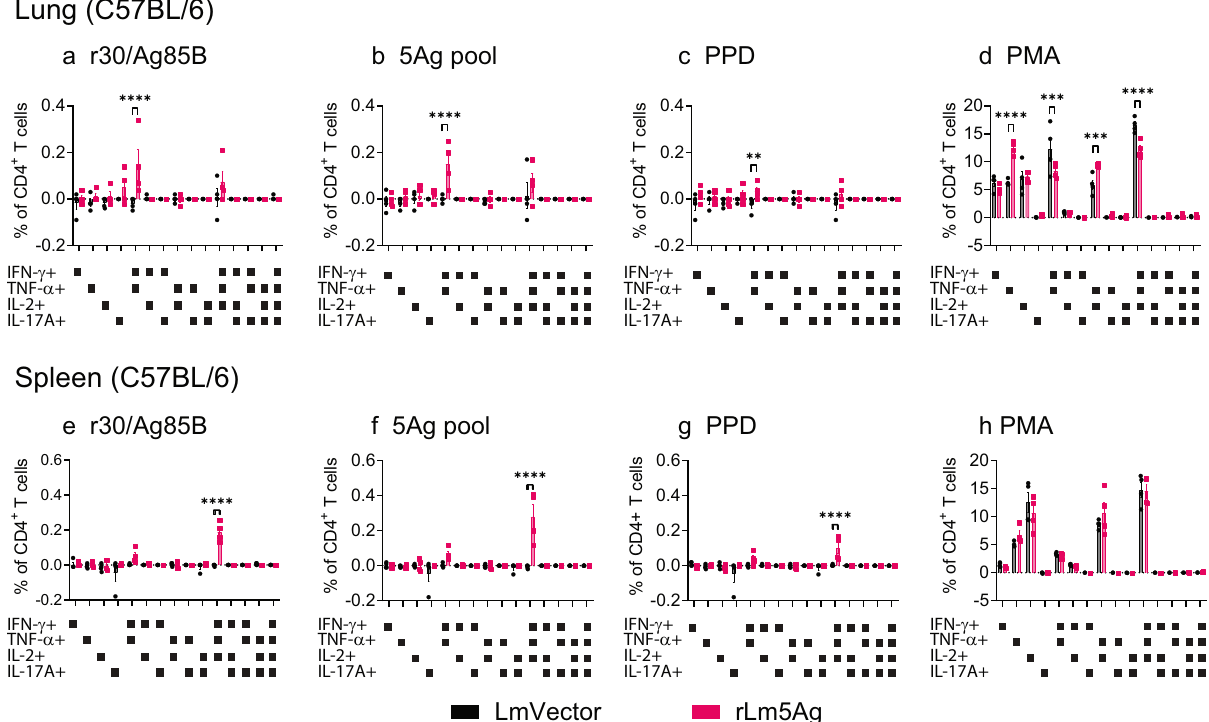
Fig. 3 Frequency of polyfunctional cytokine-expressing CD4 + T cells in the lungs and spleens of C57BL/6 mice immunized three times with LmVector or rLm5Ag. C57BL/6 mice ( n = 4/group, the same mice as shown in Fig. 2) were immunized three times s.q. with LmVector (black) or rLm5Ag (pink) at Weeks 0, 4, and 8. One week after the last immunization, animals were euthanized; their lung and spleen cells processed as described in the legend to Fig. 2. The lung and spleen cells were stimulated with r30/Ag85B ( a , e ), pool of 5 antigens (5Ag pool) ( b , f ), PPD ( c , g ), or PMA (positive control, ( d , h ), and assayed by intracellular cytokine staining for surface markers of CD4 and CD8 followed by CD3 and intracellular markers of IFN- γ , TNF- α , IL-2, and IL- 17A. The frequencies of live CD4 + T cells producing any of the 15 possible combinations of the four cytokines (IFN- γ , TNF- α , IL-2, and IL-17A) were uniquely distinguished by using Boolean gates of FlowJo 10 software, as indicated below each panel. Values are the mean ± SEM. ** P < 0.01; *** P < 0.001; and **** P < 0.0001 by two-way ANOVA with Sidak ’ s post multiple comparisons